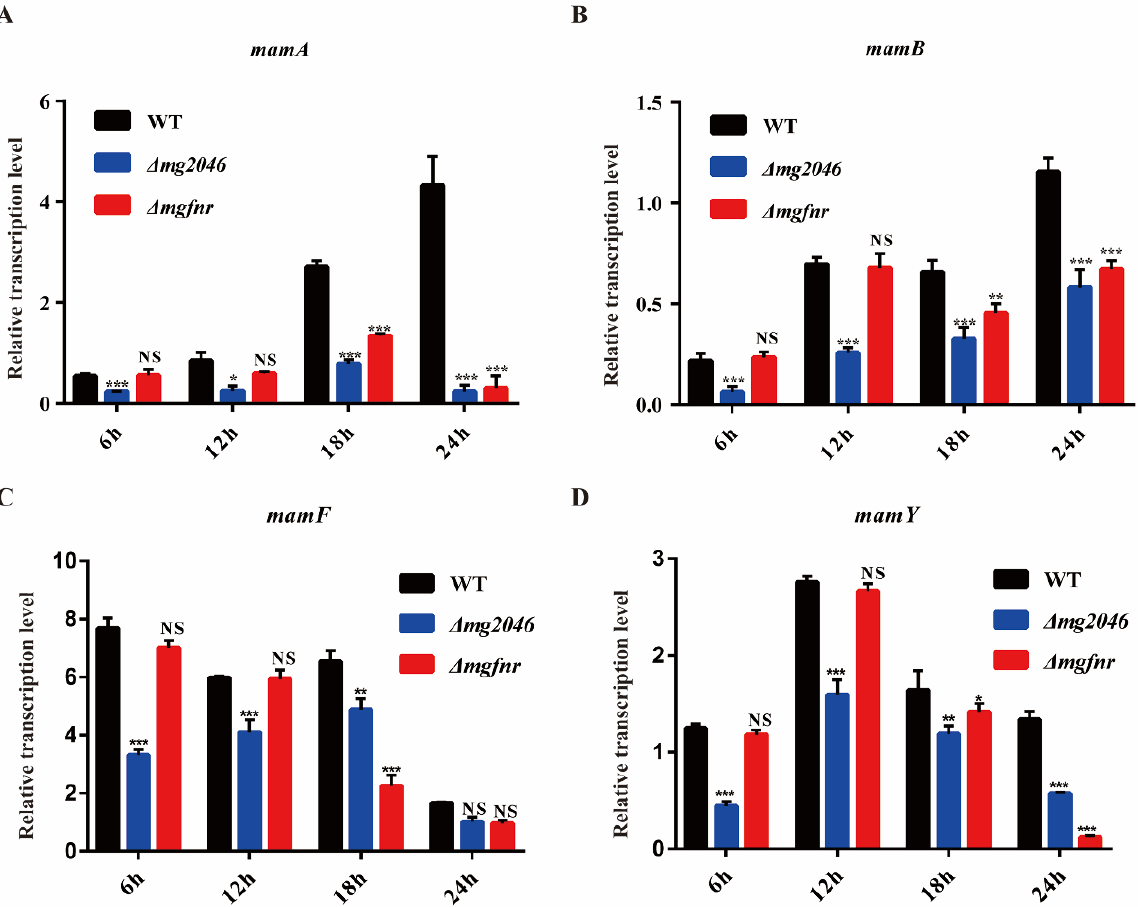
Figure 4. Relative transcription levels of MAI genes in WT, Δmg2046 , and Δmgfnr . ( A – D ): mamA , mamB , mamF , and mamY genes. Reference gene: rpoC . NS: no significant difference ( t -test). * p < 0.05; ** p < 0.01; *** p < 0.001. Error bar: SD from three replicate experiments.